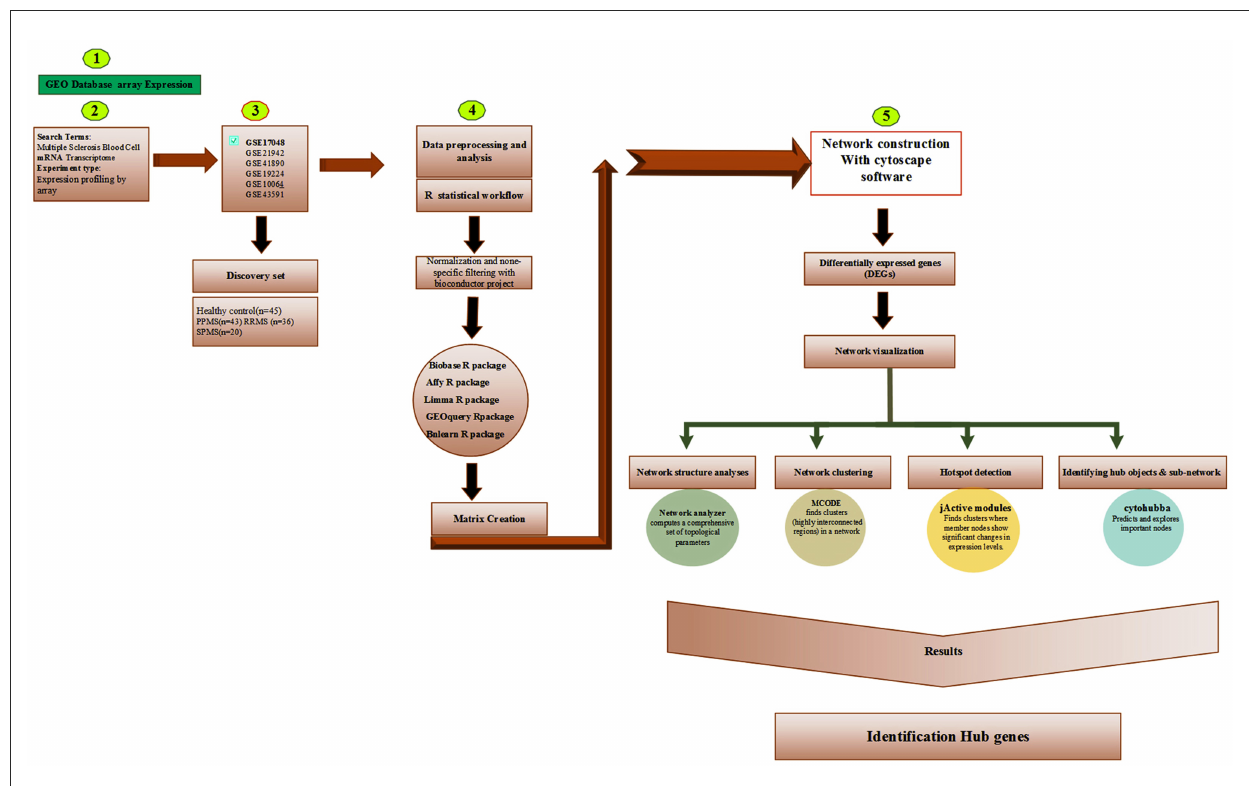
FIGURE1 The analysis pipeline used in this study 1 , 2 , 3 , 4 .